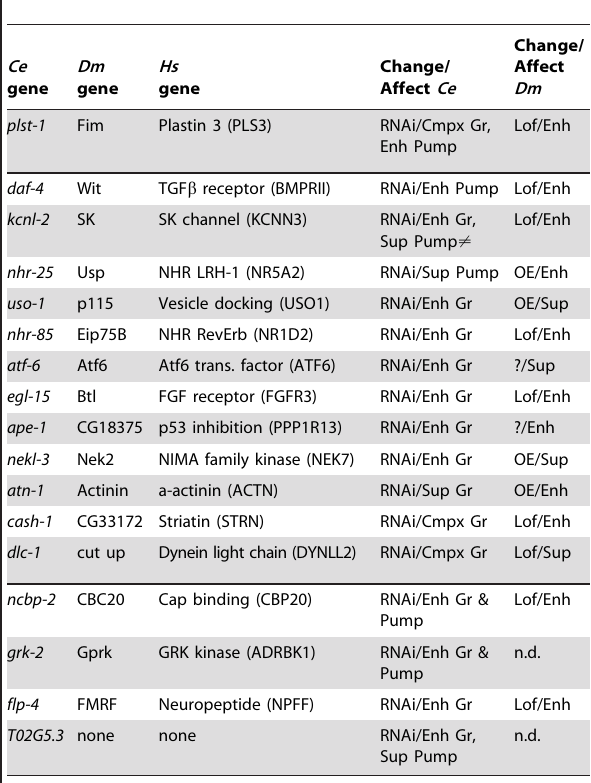
The summary table is divided into three sections corresponding to potential Cesmn-1(lf) modifier genes originally identified in humans, Drosophila , or C. elegans (1 in Hs , 40 in Dm , and 4 in Ce , respectively). Species and gene names are listed in the first three columns. The change in gene expression due to Drosophila GAL4-driven transposon insertion lines or C. elegans RNAi knockdown is listed in columns 4 and 5; effect on Drosophila gene function is predicted based solely on transposon insertion sites in some cases. (RNAi: RNAi knockdown; Lof: loss of function; decreased function or antisense; OE: over- expression; ?: unclear; Enh: enhanced SMN loss of function defects; Sup: suppressed SMN loss of function defects, Cmpx: complex genetic interaction; not determined, n.d.). Column 4 includes the C. elegans assay revealing modifier activity (Gr: growth; Pump: pharyngeal pumping.) RNAi knockdown was sufficient to modify pumping rates for T02G5.3 and ncbp-2 ; mutant alleles of grk-2 exacerbated Cesmn-1(lf) pumping defects. flp-4 loss decreased Cesmn-1(lf) pumping rates in 4 out of 5 trials, but did not reach significance overall. Discordance between Drosophila and C. elegans results is indicated with ?